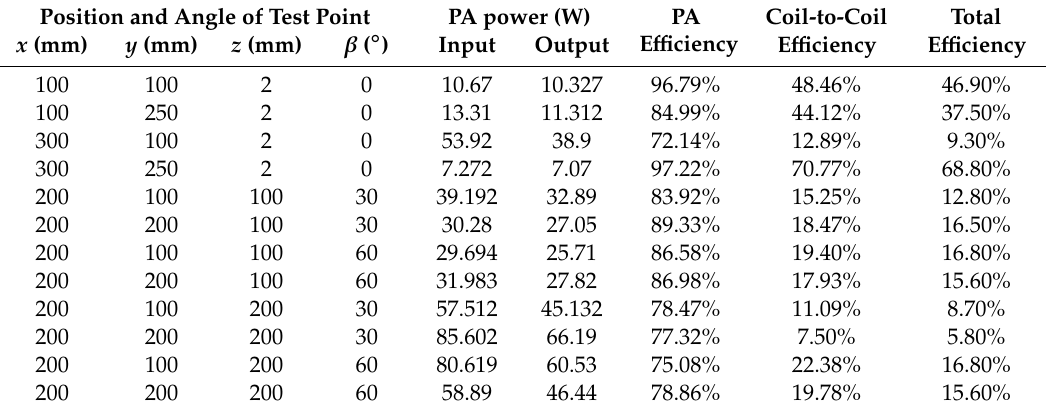
Table 3. Power amplifier (PA) power and e ffi ciency with di ff erent positional and angular misalignment of